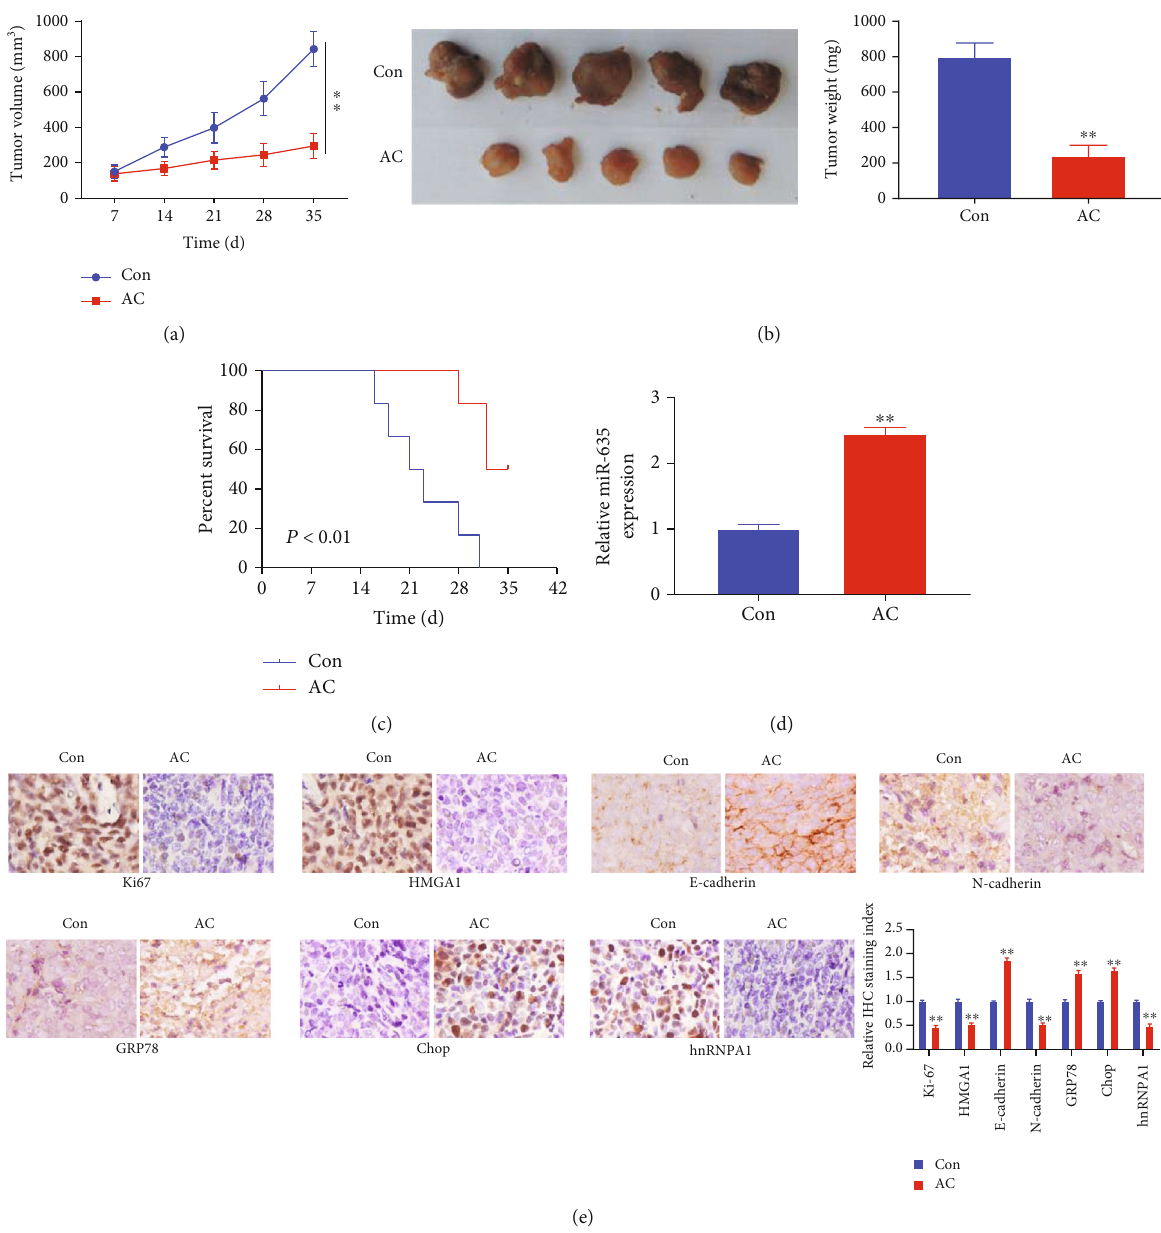
Figure 5: Asiaticoside abated tumor growth in vivo. (a) The tumor volumes of mice with or without AC administration were measured every 7 days until 35 days. (b) Images of the xenograft tumors and tumor weights from all mice at the endpoint were presented. (c) The survival rate of mice with or without AC administration was determined using Kaplan-Meier analysis. (d) The miR-635 expression in the tumor of mice with or without AC administration was detected using qRT-PCR. (e) The levels of Ki-67, HMGA1, E-cadherin, N-cadherin, GRP78, Chop, and hnRNPA1 in the tumor of mice with or without AC administration were evaluated by immunohistochemistry. ∗∗ P < 0 : 01